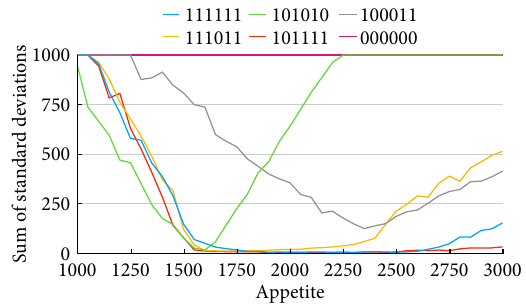
Fig. 5 Relationship between intelligence and appetite in different evolutionary environments. This analysis can be used to determine whether an agent is suitable for intelligent evolution from another point of